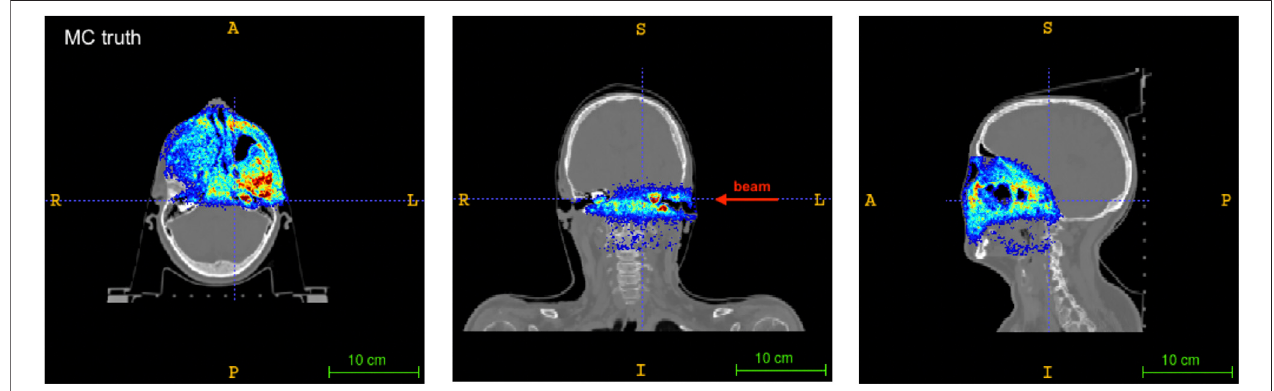
FIGURE6| Axial (left) ,coronal (center) and sagittal (right) sections ofthepatient CTwiththeMonte Carloactivity distribution superimposed. Thebeam direction is shown for the coronal slice. A standard RAI coordinate system is considered.